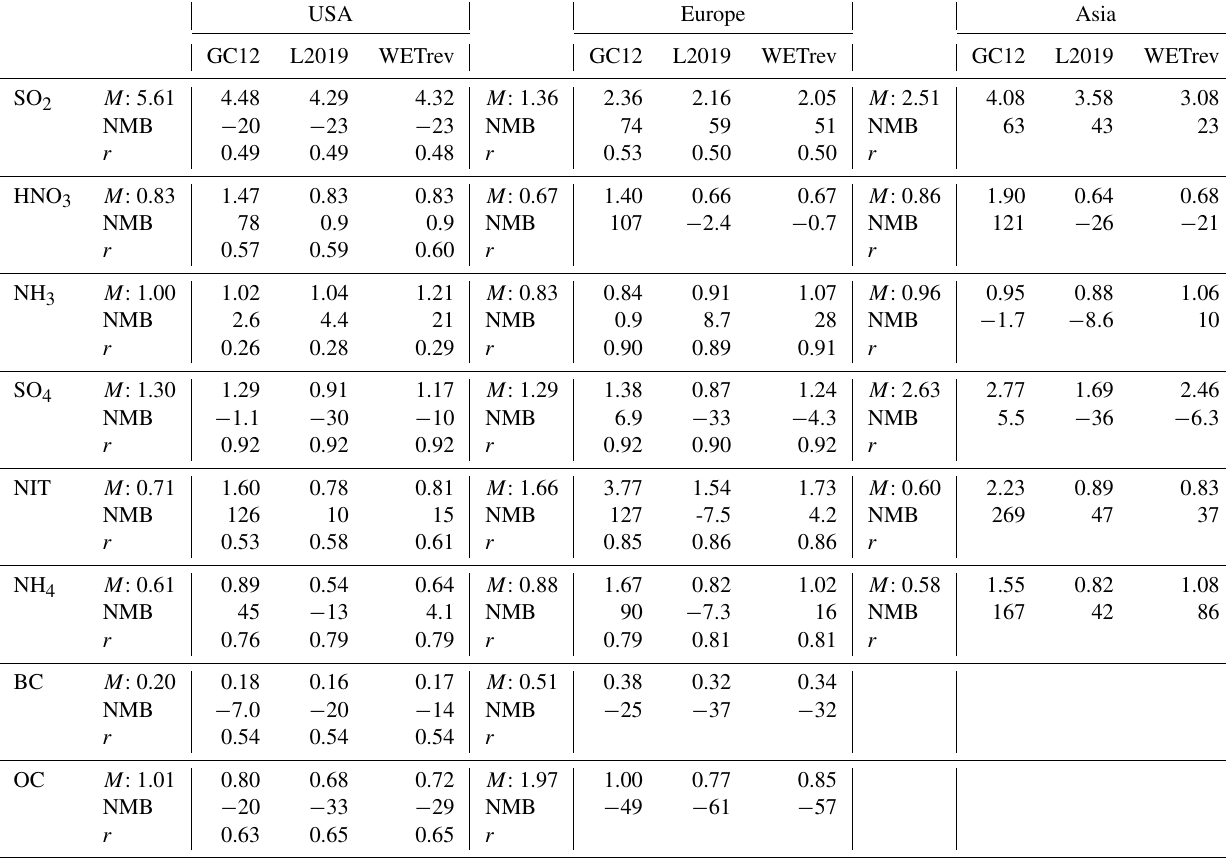
Table 3. Observed and simulated annual mean surface concentrations of aerosols and aerosol precursors in the US, Europe, and Asia. Comparisons include annual mean surface concentrations ( M , µgm − 3 ), normalized mean bias (NMB, %), and correlation coefficient ( r , when the number of samples > 10) between observed and simulated annual mean values for the eight species by GC12, L2019, and WETrev